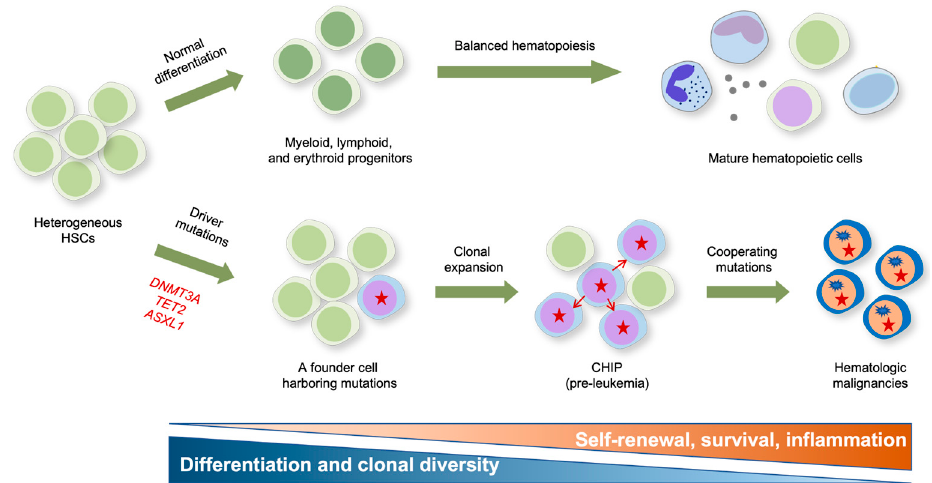
Figure 2. Impact of epigenetic mutations on the formation and clonal evolution of pre-leukemic stem cells to hematologic malignancies . A model for clonal expansion of hematopoietic stem cells (HSCs) to establish the preleukemic condition that eventually evolves into frank malignancies is shown. Healthy HSCs self-renew and differentiate into multipotent progenitors that give rise to functional tri-lineage hematopoietic cells in the periphery ( upper panel ). However, aging HSCs acquire somatic mutations in genes encoding the key epigenetic modifiers DNMT3A and TET2 that confer competitive fitness advantage and drive the clonal expansion of mutant HSCs, resulting in CHIP ( lower panel ). DNMT3A mutation is presumed to mainly influence multipotency (i.e., self-renewal), and TET2 mutations preferentially influence inflammation and myeloid bias, respectively. The pre-leukemic stem cells eventually evolve into full-blown malignancies after acquiring subsequent cooperating mutations in genes encoding FLT3, ASXL1, JAK2, EZH2, NRAS, KIT, RHOA, DNMT3A, SRSF2, AML-ETO1 , etc.